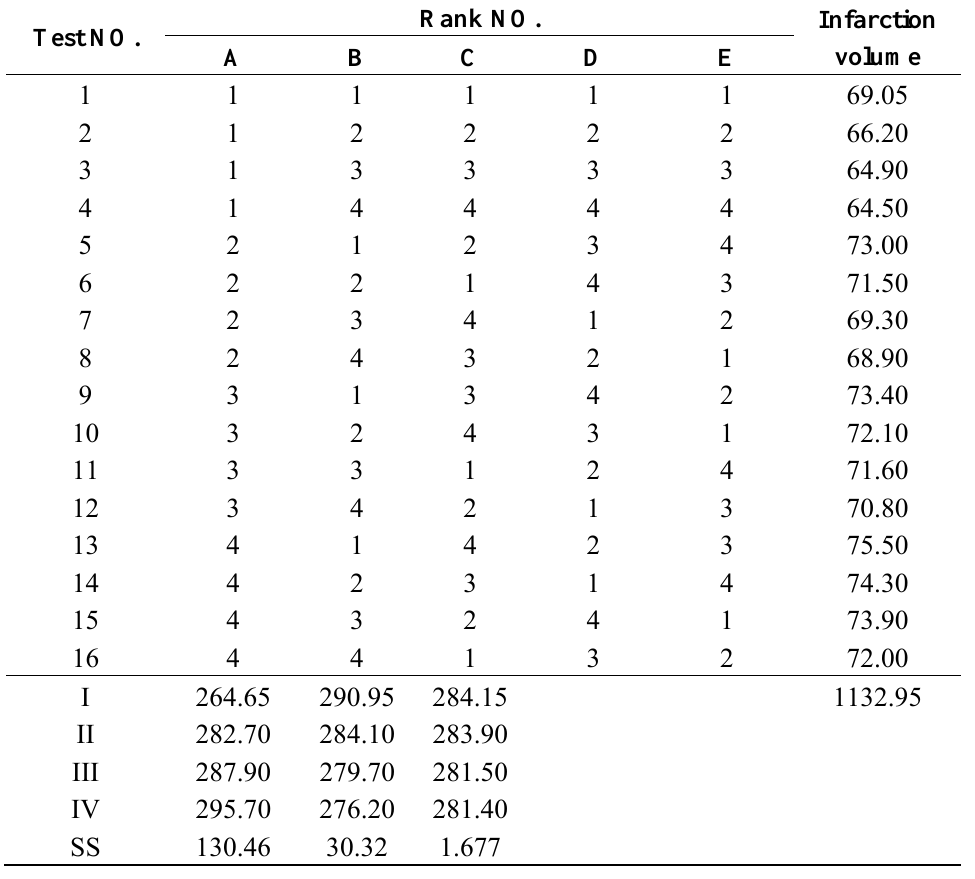
Table 9. [ L (4 5 )] orthogonal layout and the results of infarction volume. 16 Rank Test NO.